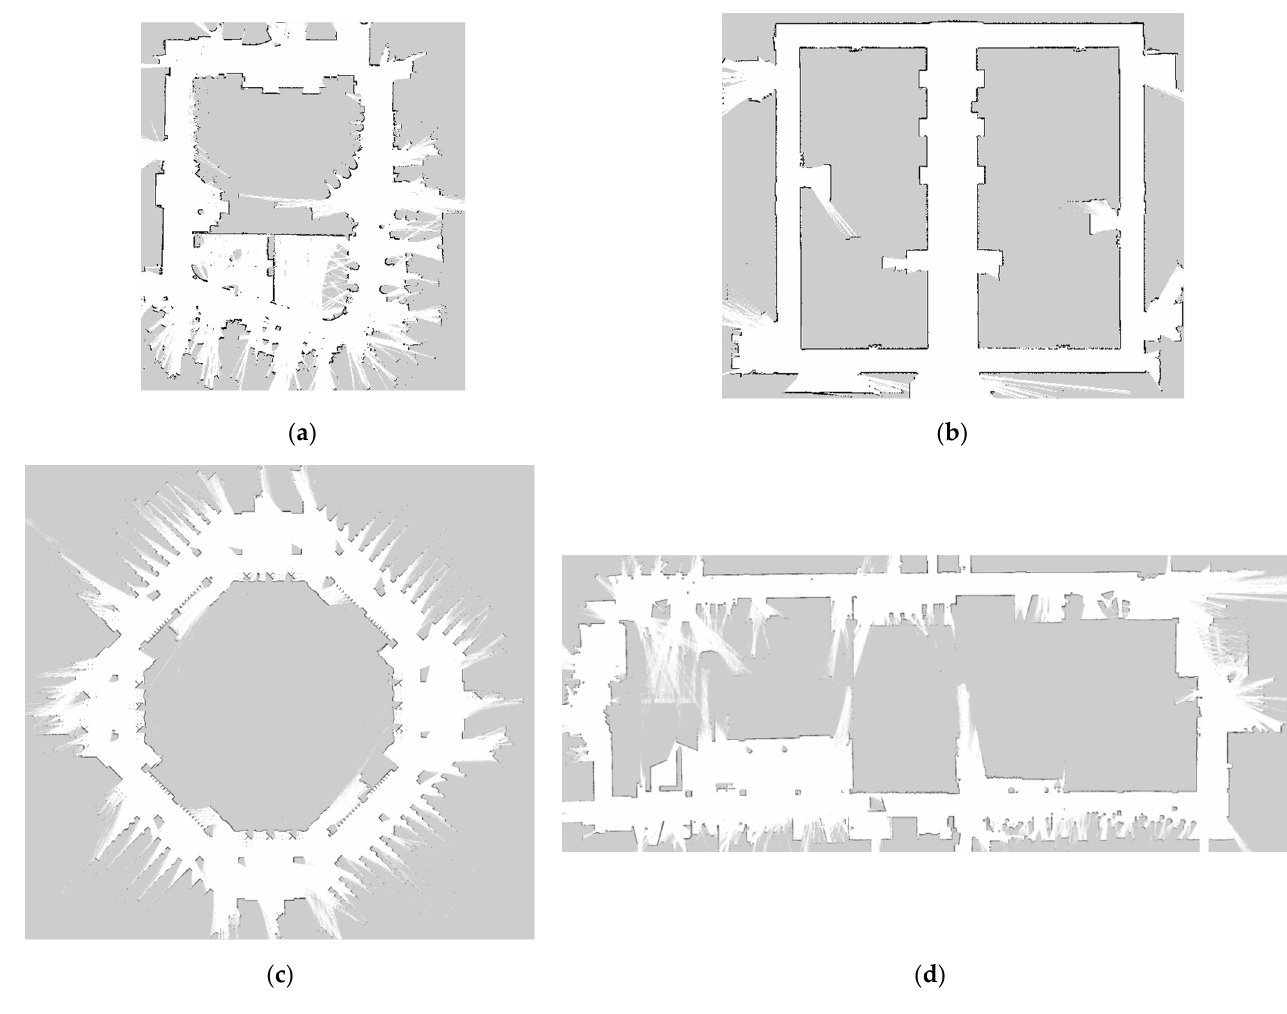
Figure 5. Maps of the test environment. ( a ) Office map; ( b ) office building map; ( c ) library map; ( d ) shopping mall map.